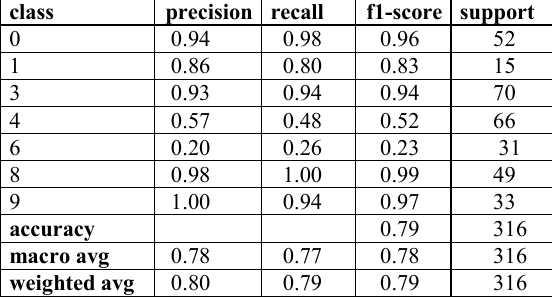
Table 9. Accuracy metrics calculated for object-based approach.